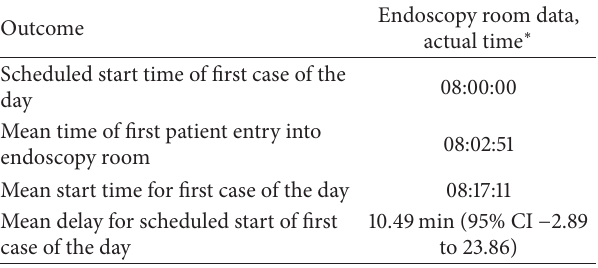
Table 4: Mean start times of first case of the